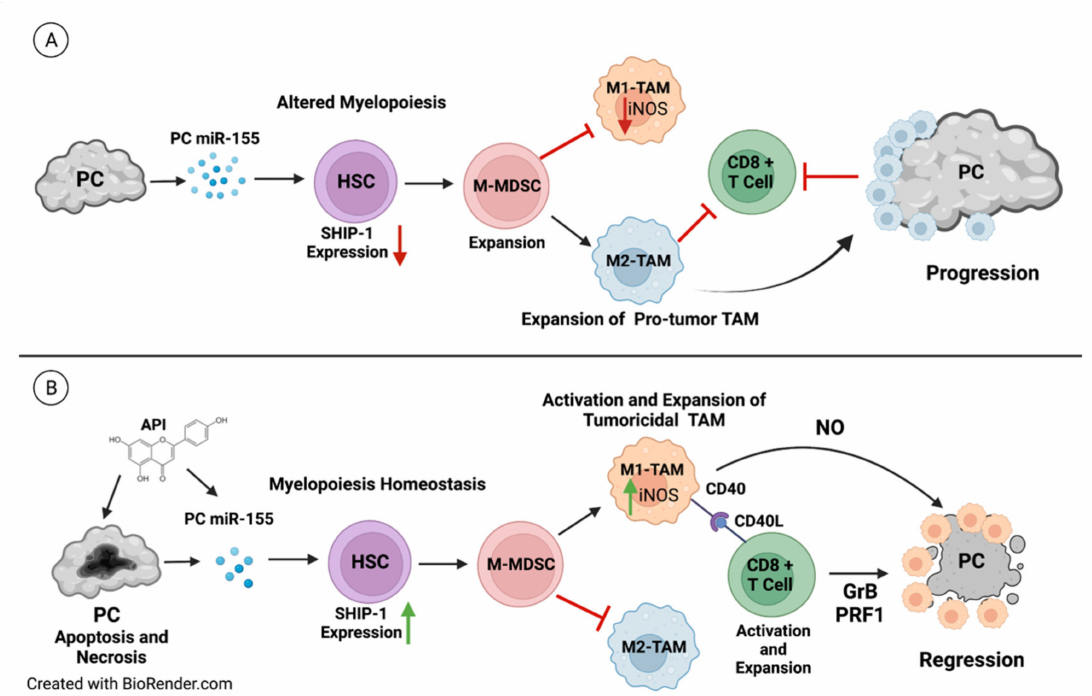
Figure 11. Proposed Model: ( A ) In the PC tumor microenvironment, tumor derived factors such as PC-induced miRNA-155 impacts hematopoietic stem cells (HSC) and alters myelopoiesis by targeting and downregulating SHIP-1 gene and protein expressions. The reduction in SHIP-1 expression corresponds with the expansion of M-MDSC that correspond with the development of pro-tumor M2-TAM which, in turn, impair anti-tumor immunity and result in PC progression and metastasis. ( B ) The therapeutic use of the bioflavonoid API induces apoptosis and necrosis of PC cells and causes a decrease in miRNA-155 in the pancreatic tumor. This reduction correlates with an increase in SHIP-1 gene and protein expressions that results in the expansion of M-MDSC which coincides with the development of tumoricidal M1-TAM. These tumoricidal M1-TAM have increased CD40 expression which interacts with CD40L on CD8 + T cells, resulting in M1-TAM activation, production of iNOS/NO and an overall increase in anti-tumor immunity. This is signified by the release of granzyme B (GrB) and perforin (PRF) as well as the robust activation of effector CD8 + T cells, leading to PC regression. Created with BioRender.com (accessed on 21 March